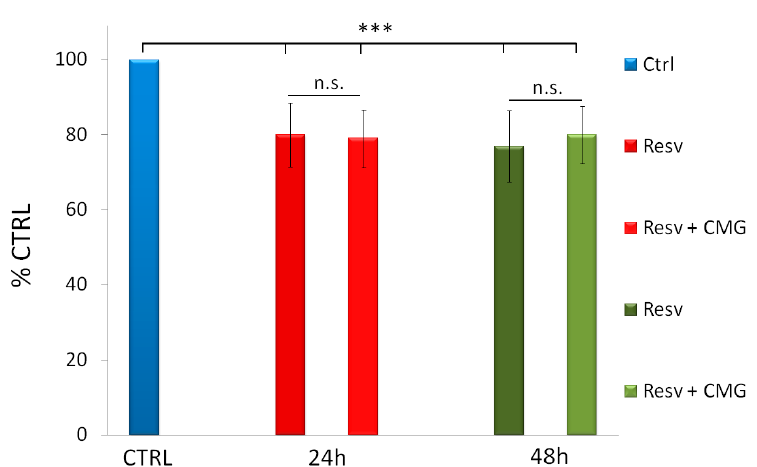
Figure 7. HeLa cell viability after 24 or 48 h incubation with 100 µ M resveratrol (Resv) in the presence or in the absence of 0.05 mg/mL CM-glucan (CMG). Values are mean ± S.D. and expressed as percent versus control cells. *** p < 0.001 vs. CTRL.